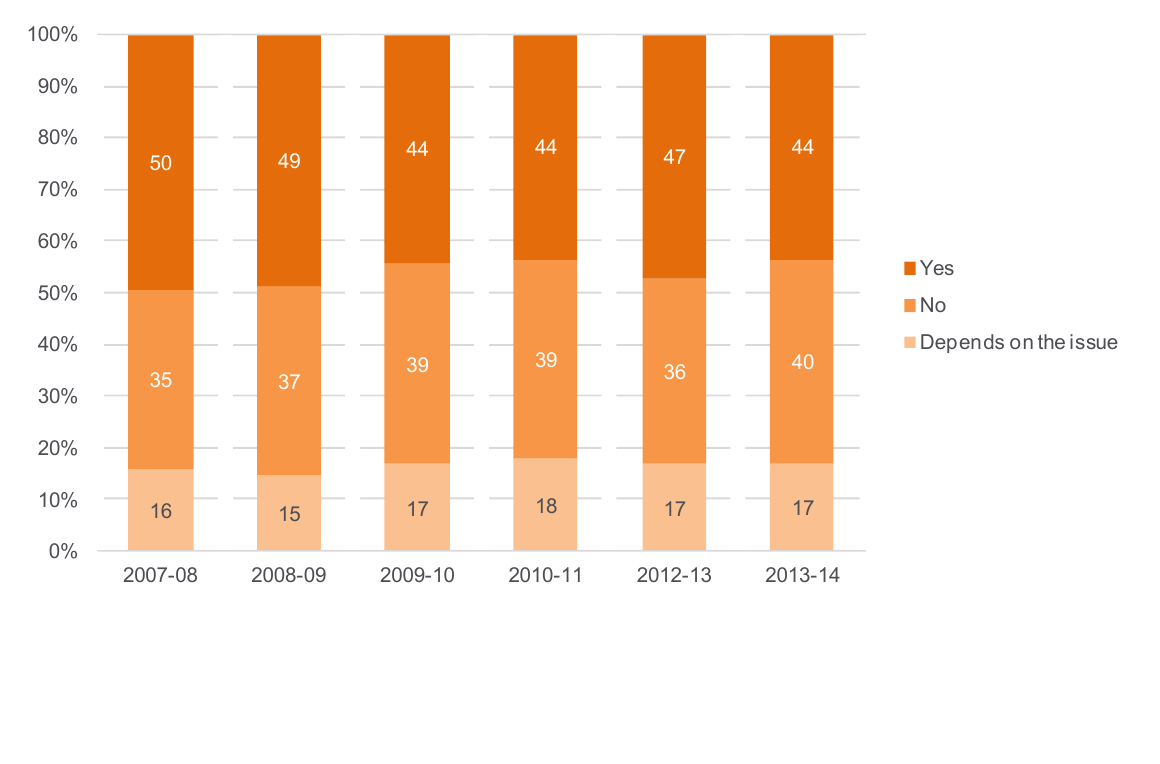
Figure 20: Whether people would like to be more involved in decisions made by the council affecting their local area, 2007-08 to